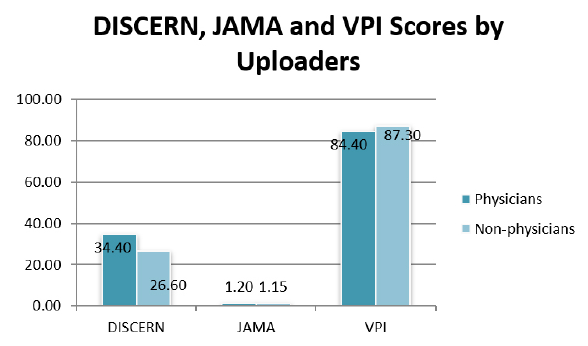
Fig. 6. Comparison of the mean DISCERN and JAMA scores and the VPI index of the YouTube videos for physicians and